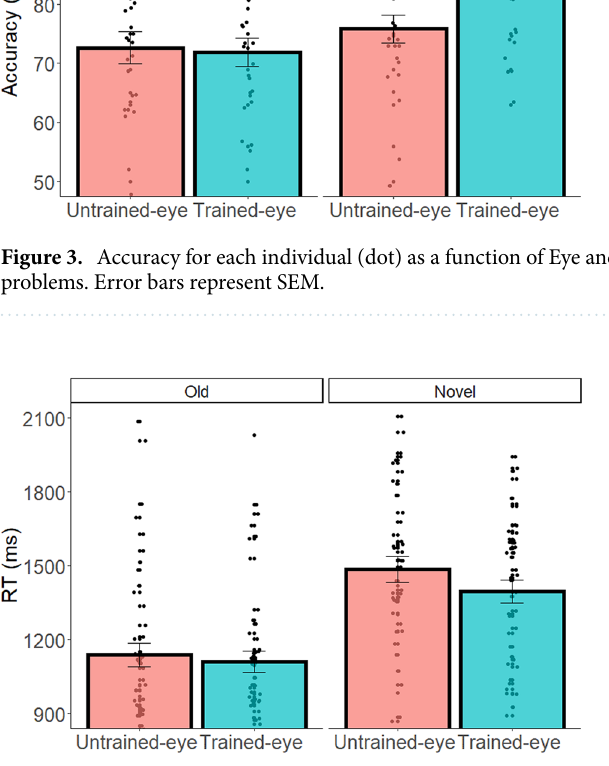
Figure 4. RT for each individual (dot) as a function of Eye and Problem Novelty in the figural-spatial task. Error bars represent